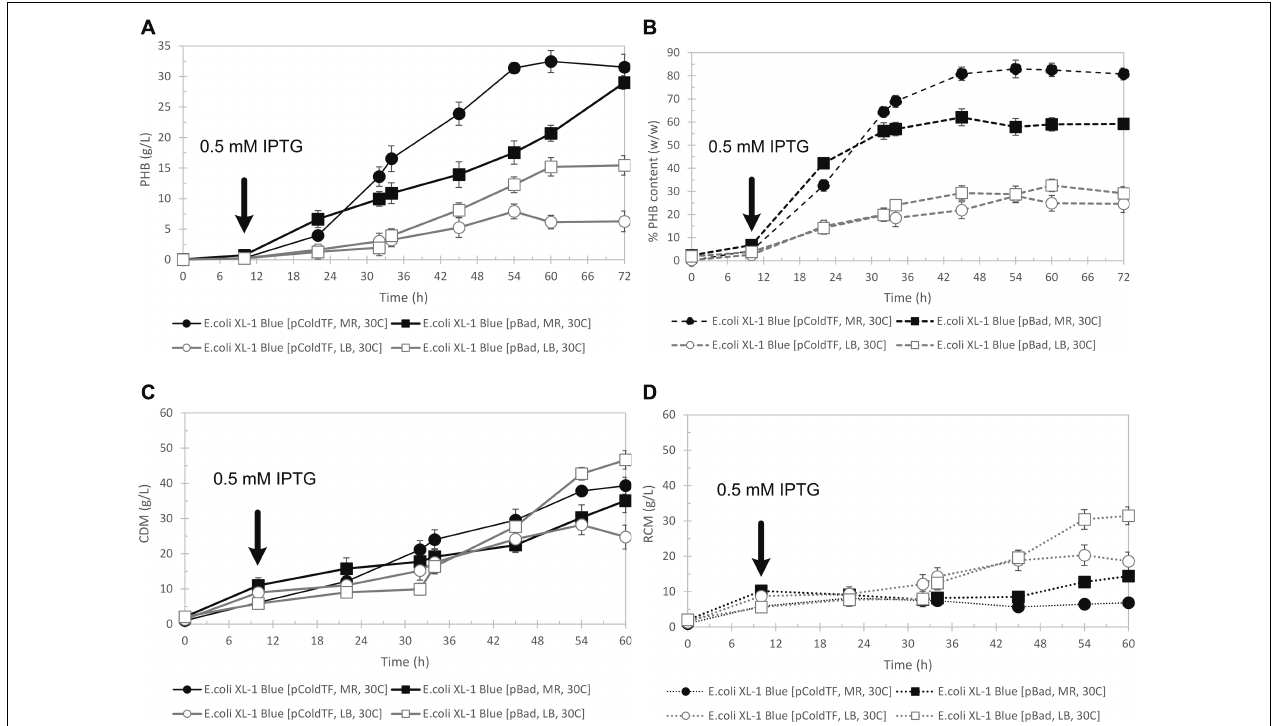
FIGURE 6 | Time courses of PHB g/L (A) , PHB content % (w/w) (B) , CDM (g/L) (C) , and RCM (g/L) (D) during batch cultivation in a 5-L fermenter in comparison between pBAD/Thio-TOPO- phaCAB A - 04 and pColdTF- phaCAB A - 04 -expressing E. coli XL1 blue-cultured in LB medium and MR